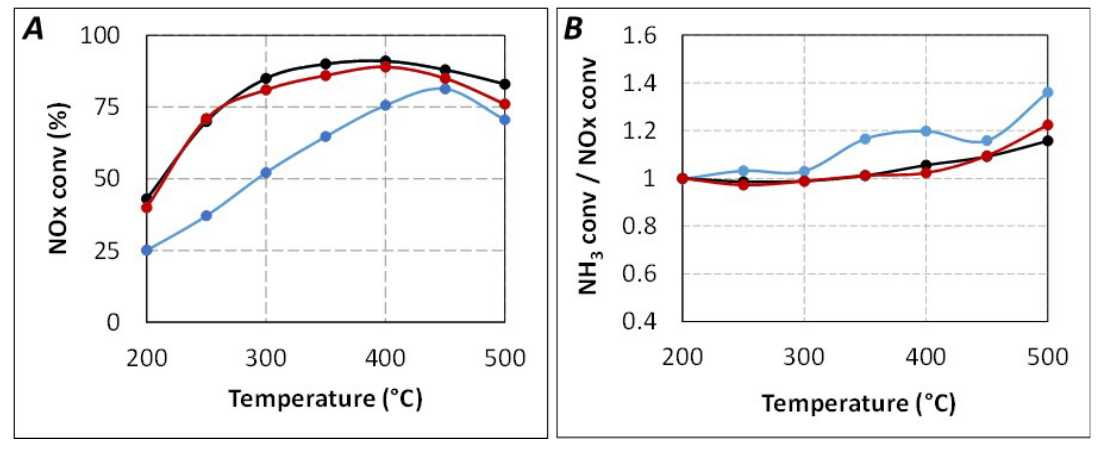
Figure 2. Influence of urea residence time in standard-SCR (400 ppm NO, 400 ppm Equation NH 3 , 8% H 2 O, 10% CO 2 , 10% O 2 ) in ( A ) NO x conversion; ( B ) NH 3 conversion/NO x conversion ratio. (▬) : t R = 4.0 s; (▬) : t R = 5.2 s; (▬) : t R = 6.1